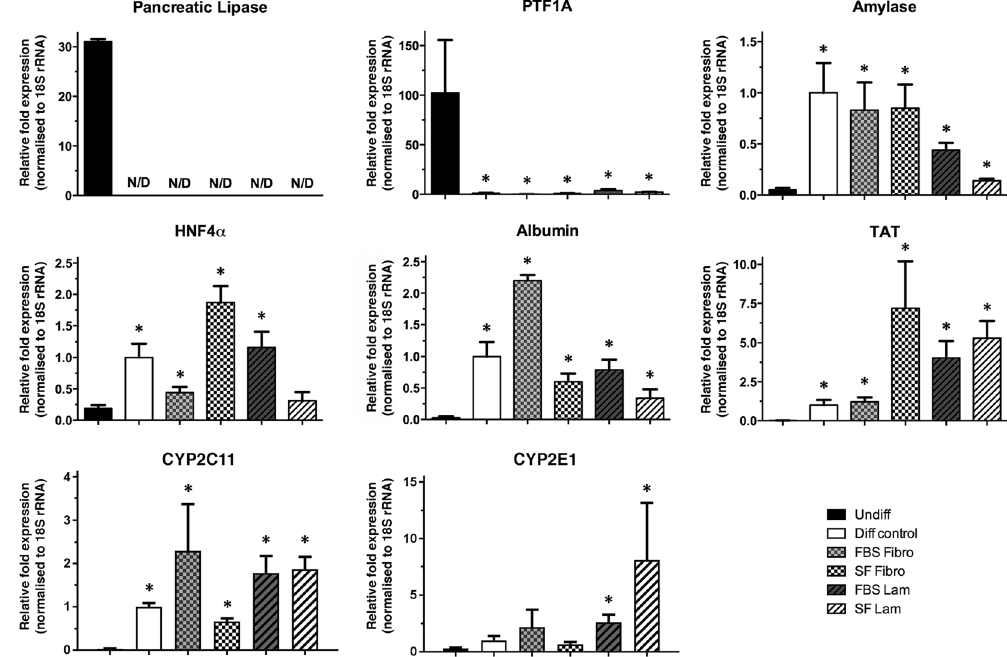
Figure 3. Gene expression of pancreatic (pancreatic lipase, pancreas-specific transcription factor 1a, amylase) and hepatocytic markers (hepatocyte nuclear factor 4 α , albumin, tyrosine aminotransferase, cytochrome P450 2C11 and 2E1) in undifferentiated AR42J-B13 cells and cells subjected to differentiation-inducing conditions on day 5. The data are expressed as means ± SEM with n = 3–5 and * p < 0.05 compared with undifferentiated cells. Undiff - undifferentiated cells; Diff control - differentiation control, with FBS, on plastic; FBS Fibro - differentiation medium, with FBS, on fibronectin; SF Fibro - differentiation medium, serum-free, on fibronectin; FBS Lam - differentiation medium, with FBS, on laminin; SF Lam - differentiation medium, serum- free, on